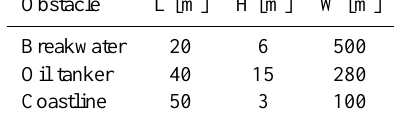
Table 2. Characteristic lengths of the anthropic structures as adopted in the simulations.